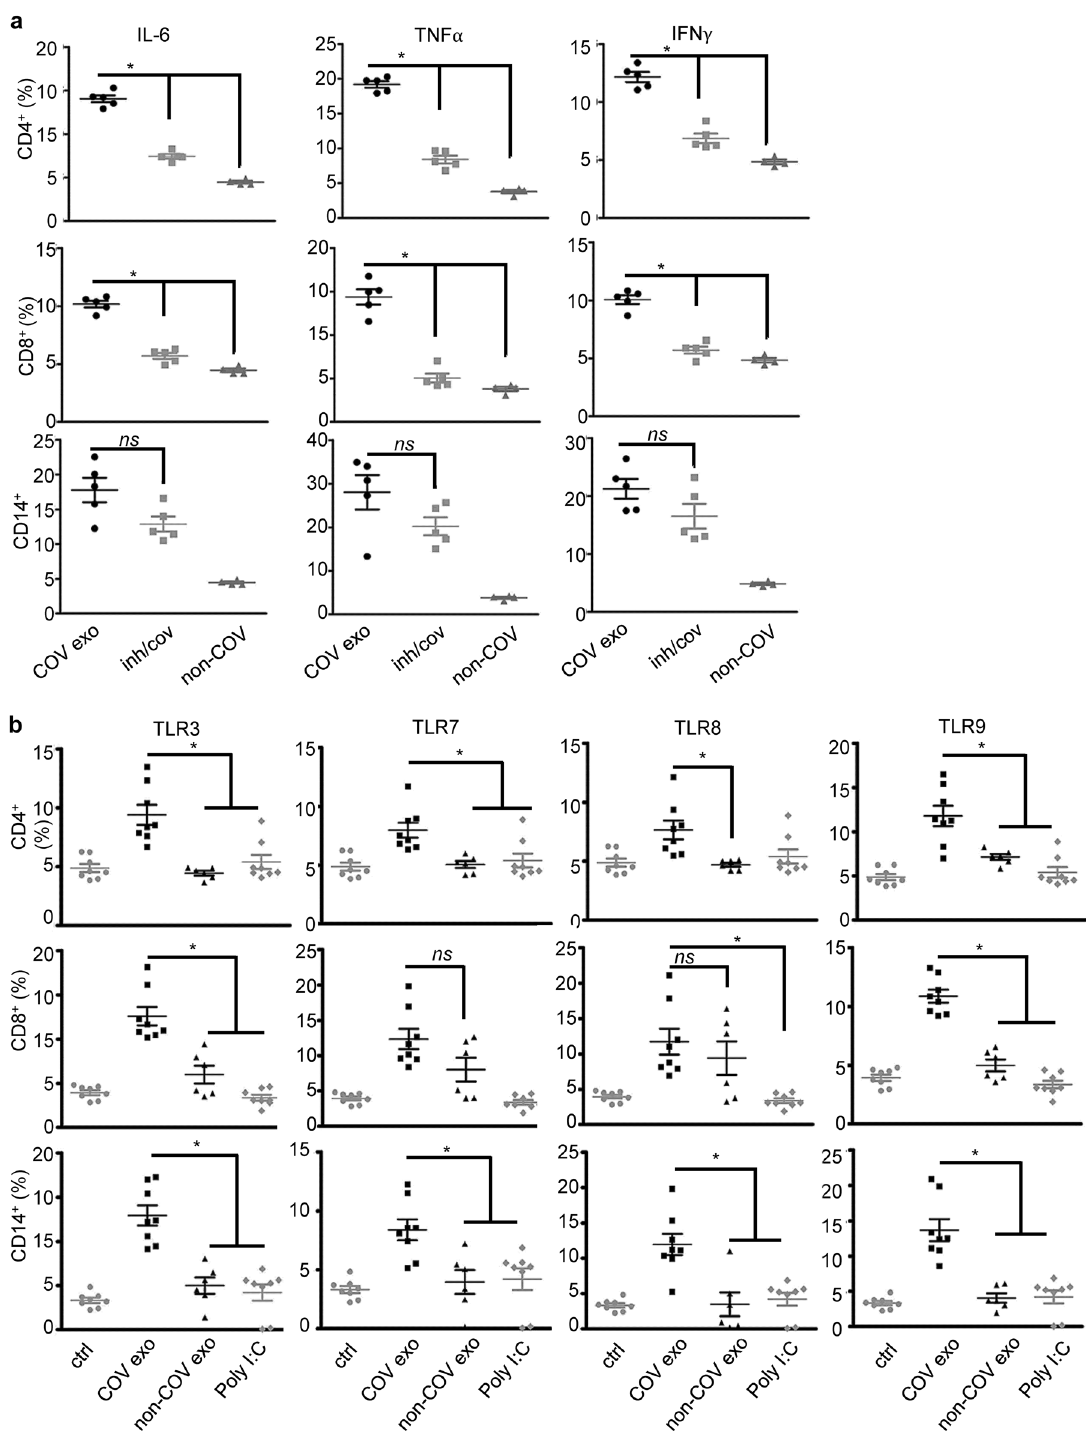
Figure 6. Cytokine production and TLRs in response to plasma exosomes. ( a ) PBMCs were treated with the TLR3 inhibitor (10 µM) for 30 min or remained untreated, followed by stimulation with plasma exosomes (4 × 10 9 ml −1 ) for 16 h. Production of cytokines was determined by flow cytometry gated on CD4 + , CD8 + , and CD14 + . COV exo, COVID-19 plasma exosome treatment; inh/cov, TLR3 inhibitor treated and COVID-19 plasma exosomes stimulated; non-COV, treatment with non-COVID plasma exosomes. * p < 0.05; ns , p > 0.05. ANOVA, equal variants. ( b ) CD4 + T cells, CD8 + T cells, and CD14 + monocytes were isolated from PBMC using MicroBeads, followed by treatment with plasma exosomes from COVID-19 patients upon admission (COV exo, 4 × 10 9 ml −1 ), non-COVID donors (non- COV exo, 4 × 10 9 ml −1 ), or poly(I:C) (5 µg ml −1 ) for 16 h at 37 °C. Expression of TLR3, TLR7, TLR8, and TLR9 was determined by flow cytometry gated on live cells. Isotype antibodies and no-antibody blanks were used in each flow cytometry assay. ctrl, medium only control. Error bars, ± SD; * p < 0.05; ns , p > 0.05; one-way ANOVA. Isotype antibody controls and blank controls were performed in parallel in flow